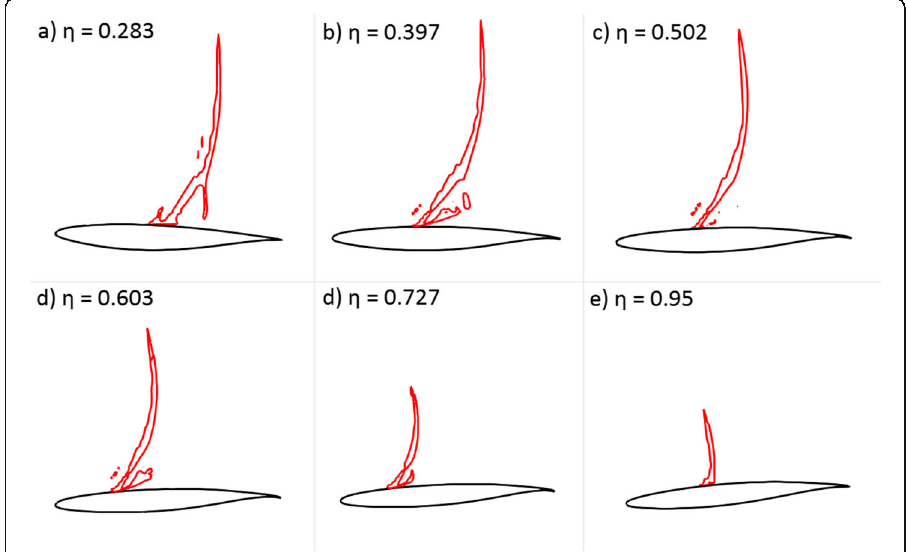
Fig. 14 Instantaneous (t = 1.2 s) slices of Normal Mach = 1 shock detection criterion at different spanwise locations. Flow conditions M = 0.85, Re = 5 m, α =